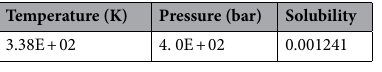
Table 3. Optimal